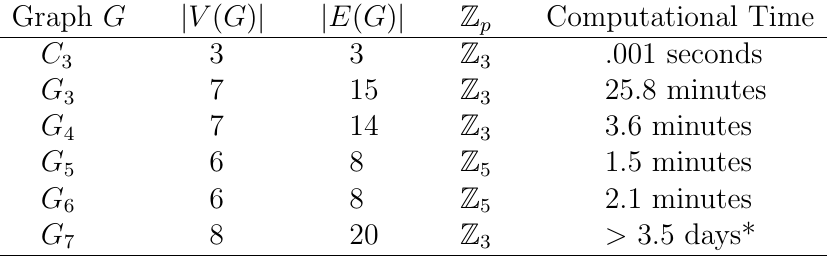
Table 1: Runtimes of calculations in Examples